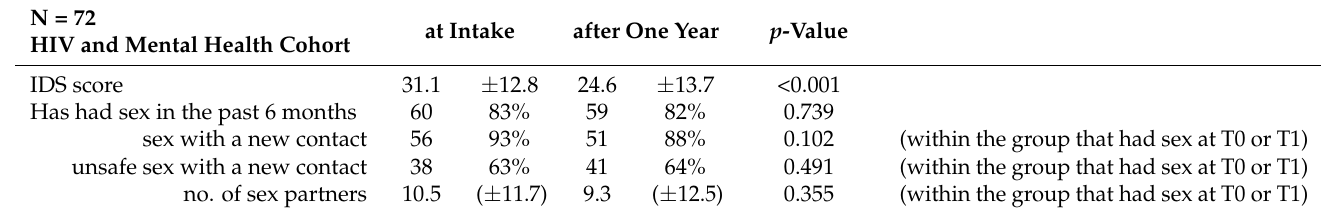
Table 3. Safe and unsafe sexual contacts at intake and after one